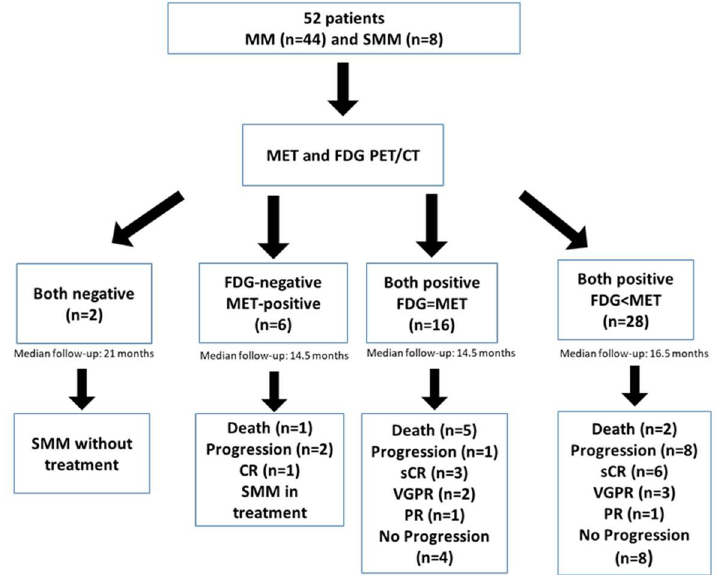
Figure 2. Flow chart of the study population.